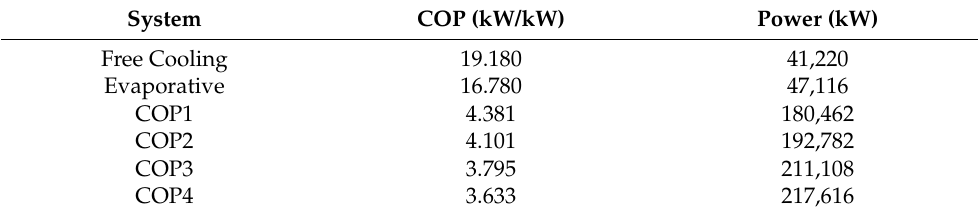
Table 6. Data for psychrometric chart for a total thermal load of 790.6